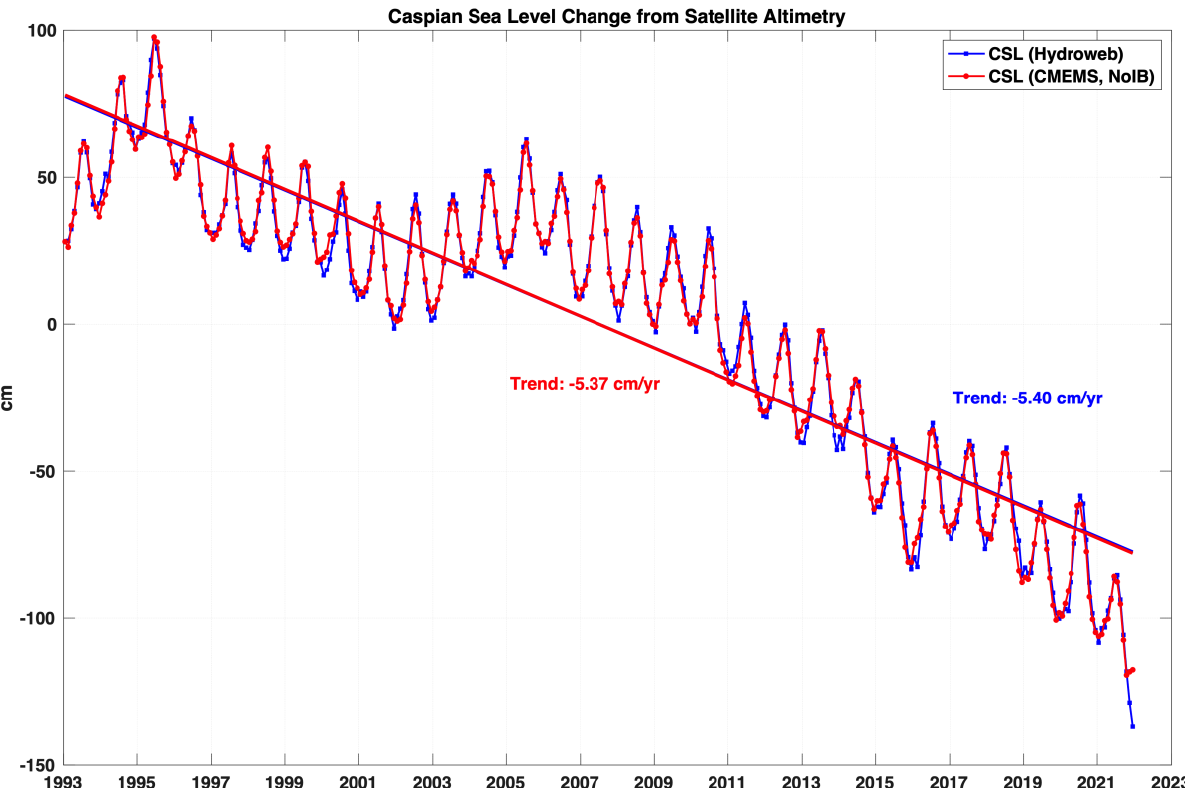
Figure 7. Monthly Caspian Sea level changes (in units of cm) observed by satellite altimeter over the period of January 1993 to December 2021, provided by the Hydroweb project (https://hydroweb.theia-land.fr/; Accessed on October 24 2022) and estimated from the CMEMS global sea level anomaly product (https://data.marine.copernicus.eu/; Accessed on July 27 2022) with the CMEMS approximate IB correction removed and replaced by the appropriate one. The two lines (red and blue) represent the linear trends estimated from least-squares fit (the two lines are mostly overlapped with each other, as the estimated trends are too close). The estimated trends, − 5.36 cm/yr, and − 5.41 cm/yr are labeled in the plot with corresponding colors.